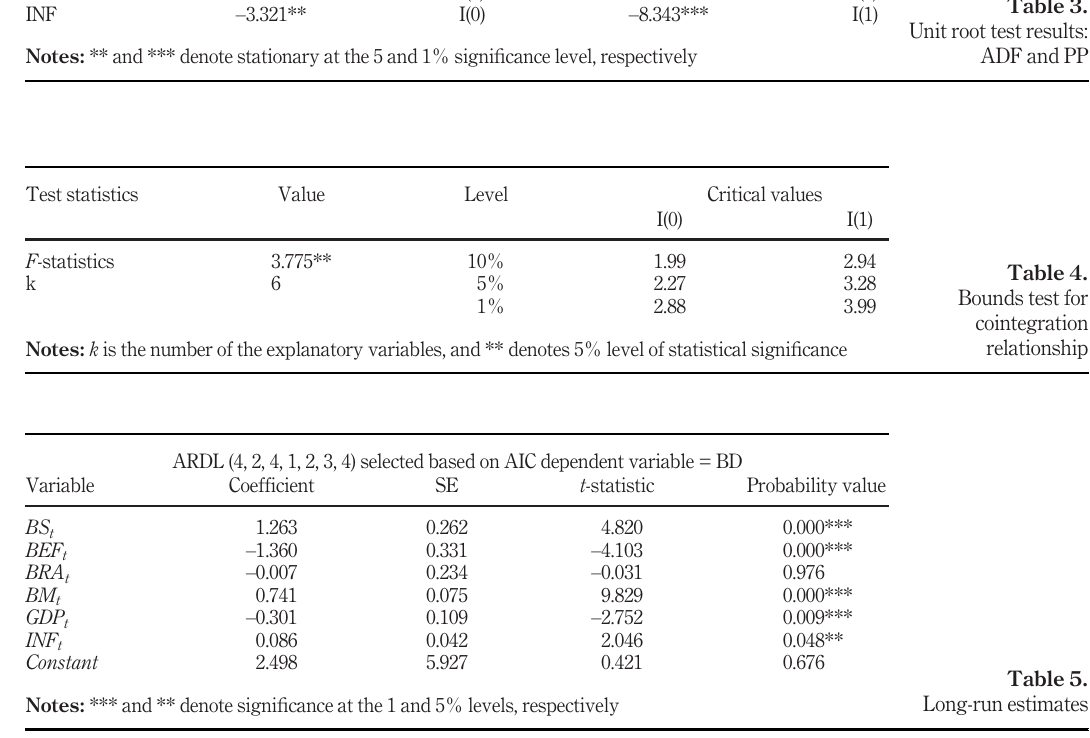
Table 3. Unit root test results: